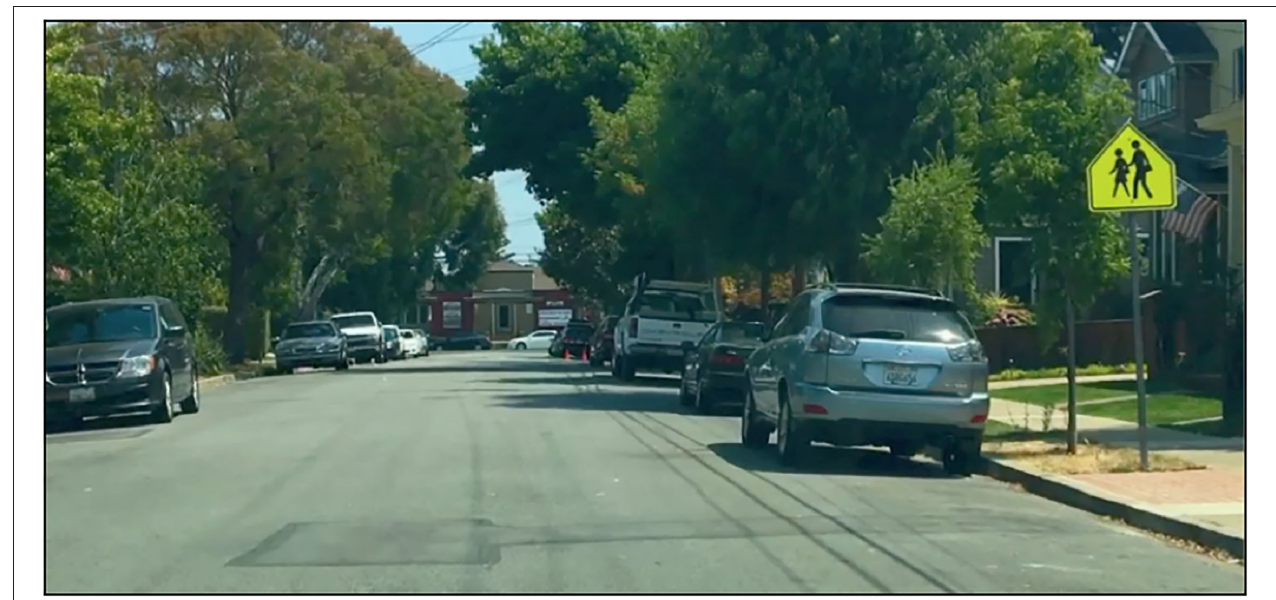
FIGURE 1 | Sample image, taken from a 24-s film clip.